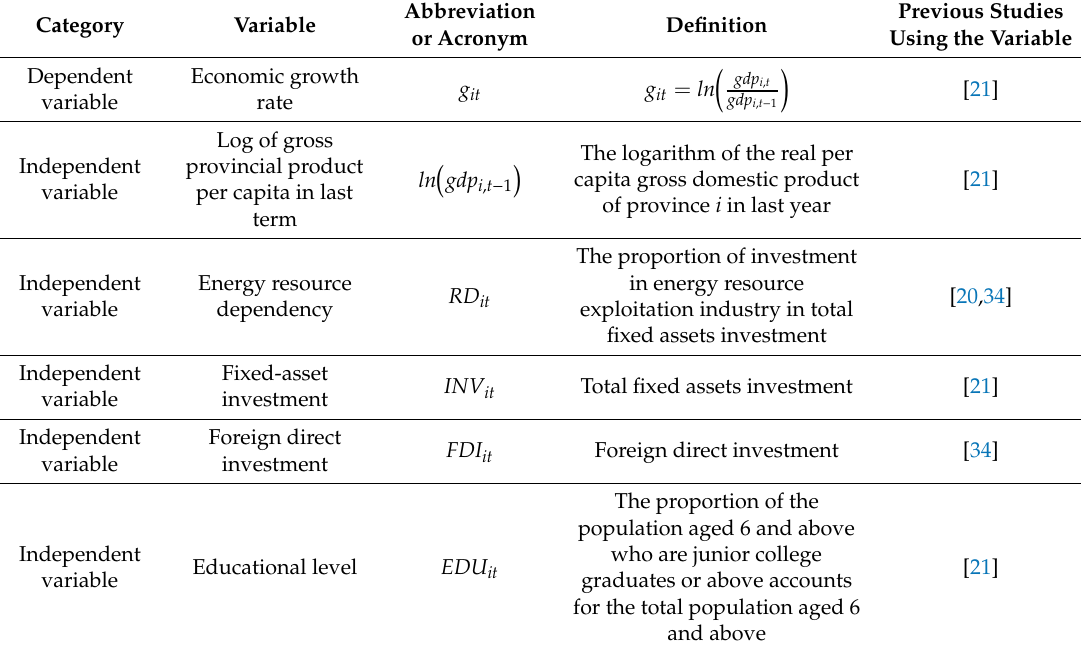
Table 1. List of variables in the regressions.